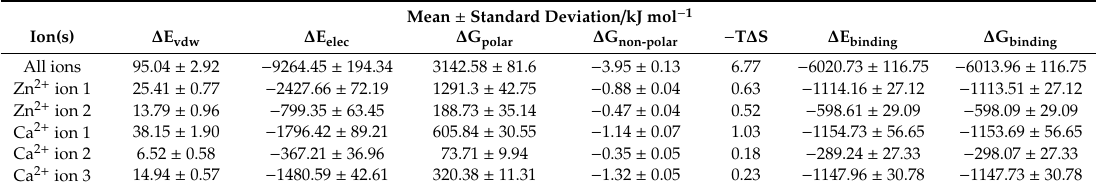
Table 5. Binding energies between MMP-2 and the associated divalent cations as determined by the MMPBSA-IE and interaction entropy methods with its associated